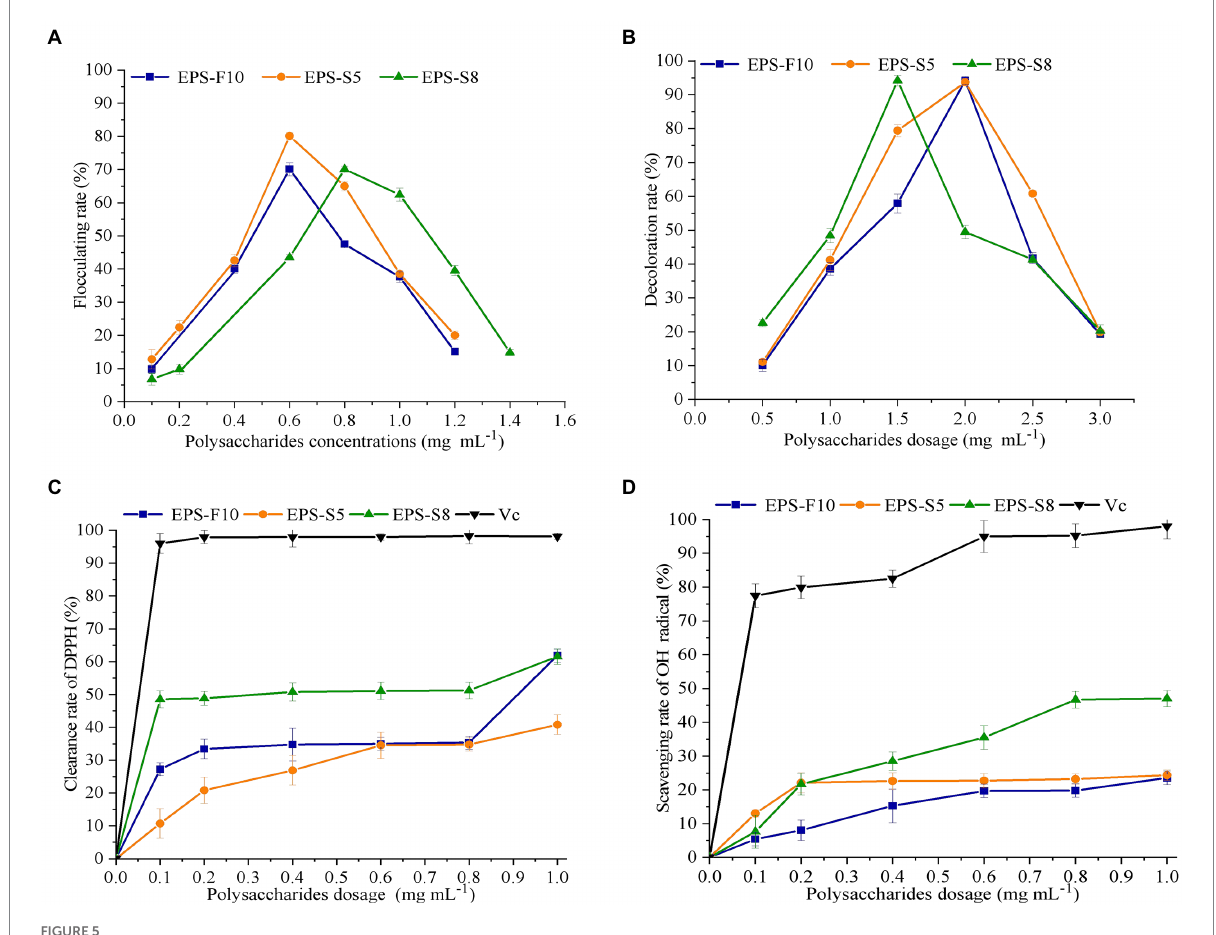
FIGURE 5 The effect of EPS dosage on flocculation rate (A) , decoloration rate (B) , scavenging activity on DPPH (C) , and OH (D)